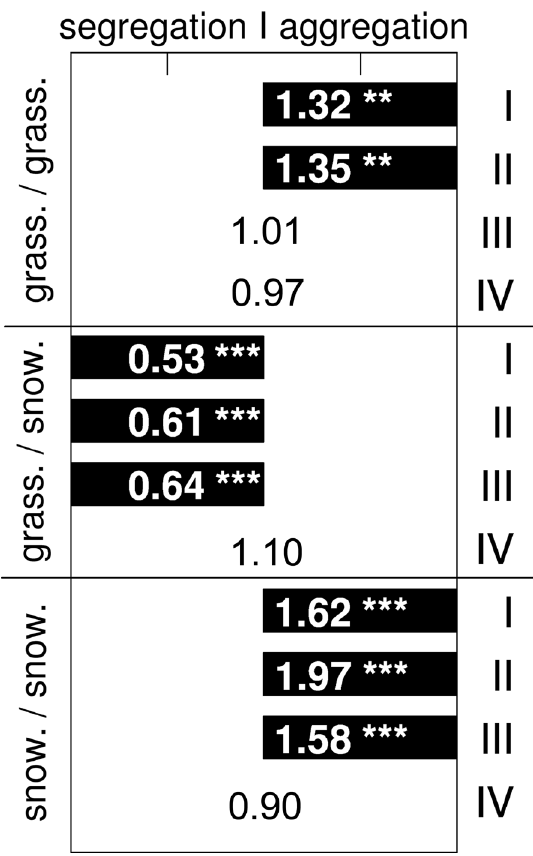
Fig. 3. Spatial relationships within and between the two oppo- nent groups of species along the snowmelt gradient. Aggregations and segregations were detected by calculating the observed vari- ance ratio (RV ) and comparison to the null model with ran- obs domly distributed species. A value of RV = 1 means a random obs distribution of species, values of RV < 1 suggest segregation, obs RV > 1 indicate aggregation. Species groups: alpine grassland obs species (grass.; snowmelt date I: 13 species, II: 11, III: 9, IV: 2) and subordinate snowbed species (snow.; I: 5, II: 7, III + IV: 8). Significant RV -values displayed in filled columns are marked obs with * (p < 0.05), ** (p < 0.01), *** (p < 0.001). Snowmelt dates: I = 2 Jun 2003, II = 9 Jun 2003, III = 16 Jun 2003, IV = 23 Jun 2003. n for each snowmelt date = 120